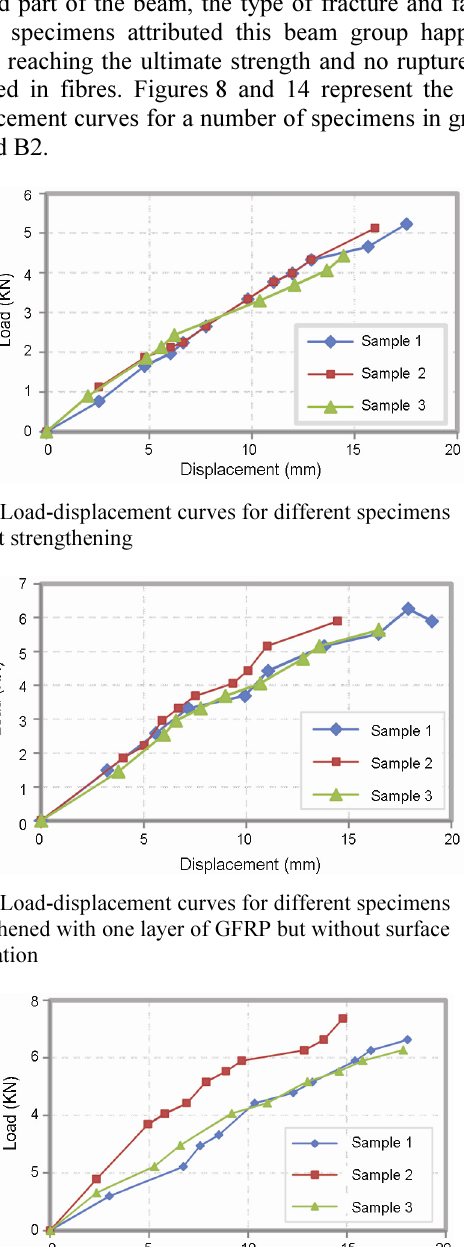
Fig. 10. Load-displacement curves for FRP-strengthened speci- mens with one layer of GFRP and with transverse grooves